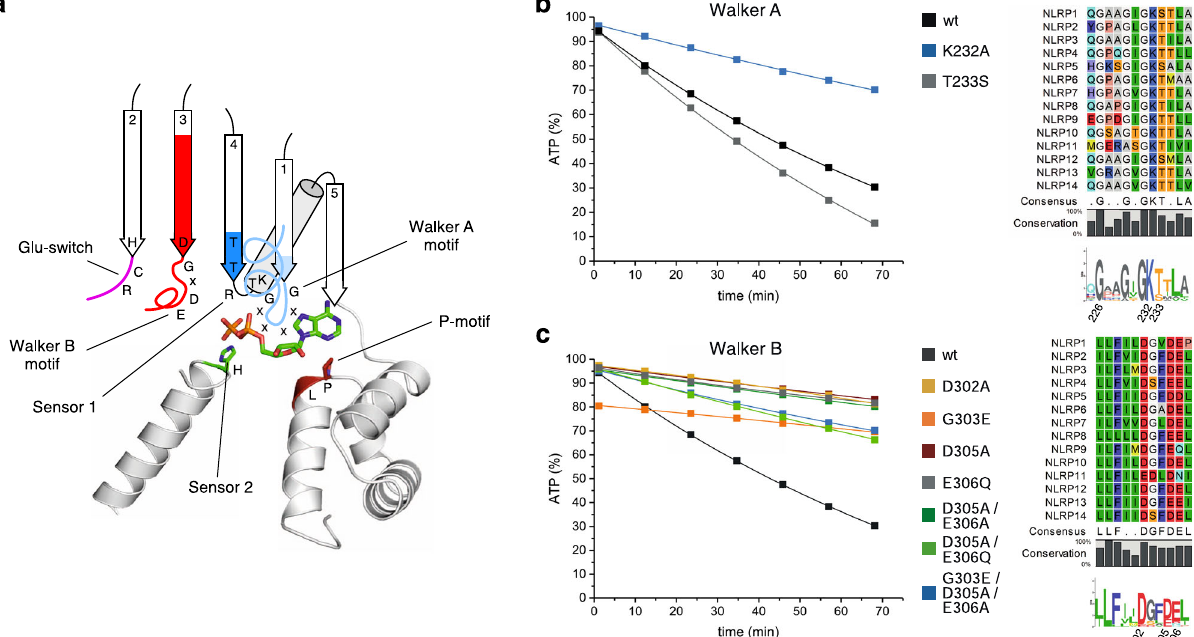
Fig. 3 Mutational analysis of Walker A/B nucleotide-binding motifs in NLRP3. a A cartoon of the nucleotide-binding site of NLRP3 including ADP is shown based on the structure of inactive NLRP3 (PDB: 7PZC). The Walker A and B motifs as well as the Glu-switch, Sensor 1, Sensor 2 and the P-motif are indicated. b MBP-NLRP3 wild type and Walker A motif point-mutants were analyzed by RP-HPLC. Sequence alignments and sequence logos of the labeled motifs and residues are shown for human NLRP1-14. Protein samples (3 µ M) were incubated at 25 °C in the presence of 100 µ M ATP and 5 mM MgCl 2 . The amount of ATP (%) is shown on the y-axis and the time (min) on the x-axis. The amount of ATP was determined in 10 min intervals using RP-HPLC, integrated and normalized to 100% nucleotide. c MBP-NLRP3 wild type and Walker B motif point-mutants were analyzed by RP-HPLC using the same set- up as in b . All mutant signi fi cantly reduced the hydrolysis activity. Table 1 ATP turnover numbers of human NLRP3 proteins. NLRP3 protein turnover (min − 1 ) fold change relative to wt peak 1